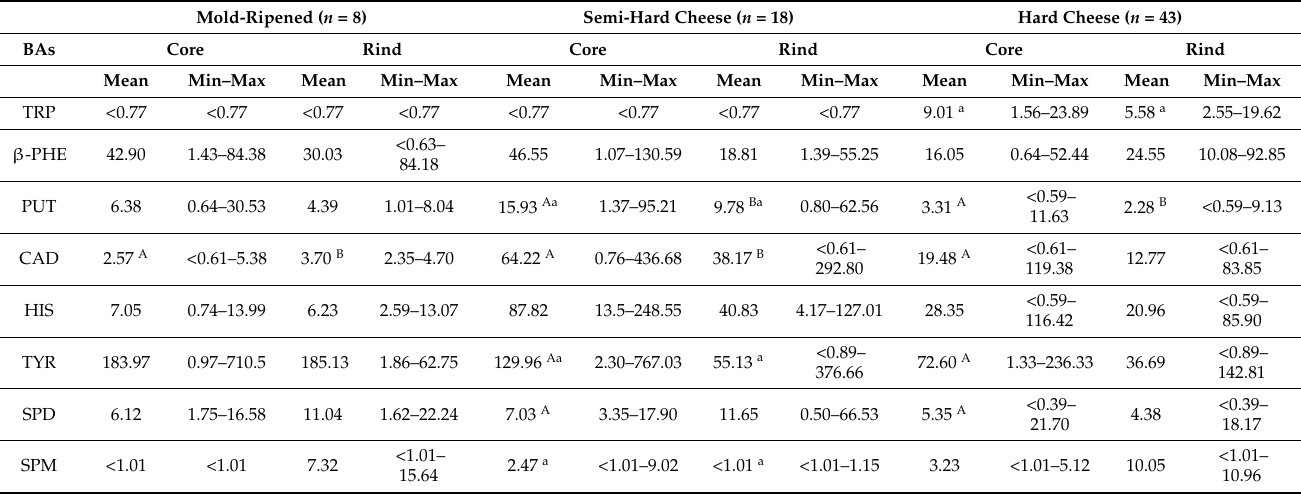
Table 3. Biogenic amine content in retailed cheese varieties ripened with mold or bacterial dairy